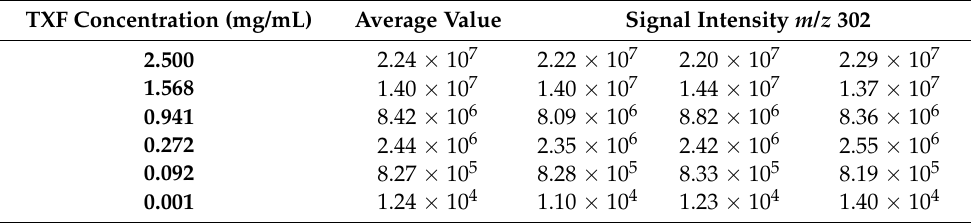
Table 1. ESI-MS results for a different concentration of